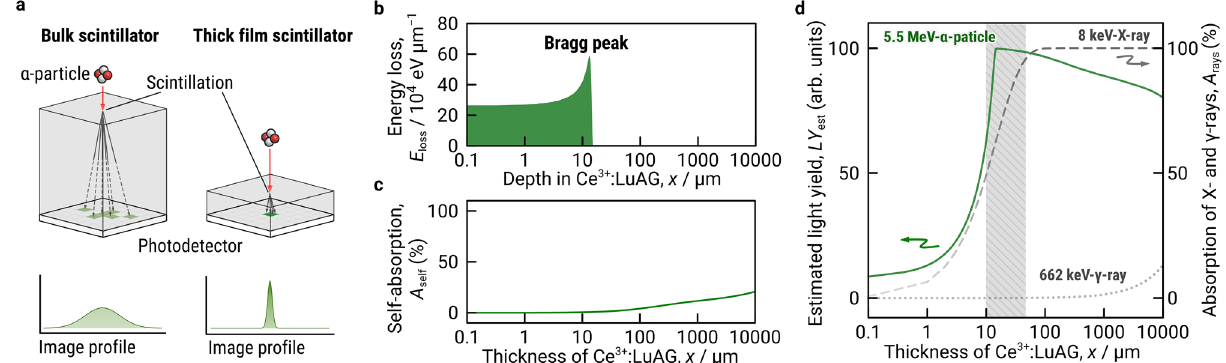
Figure 1. Estimation of optimal thickness of Ce 3+ :LuAG thick film scintillator for radiation detection. ( a ) A schematic representation of bulk and thick film scintillators coupled with photodetector for α-ray imaging (upper) and expected line profiles (lower). Dashed lines illustrate the light pass of scintillation light. ( b ) SRIM simulation of the energy loss spectrum of 5.5 MeV α-particle traveled in Ce 3+ :LuAG scintillator. ( c ) Calculated self-absorption of Ce 3+ :LuAG scintillator as a function of thickness of the Ce 3+ :LuAG scintillator for 5.5 MeV α-particle-induced radioluminescence of the Ce 3+ :LuAG scintillator. ( d ) Estimated light yield of Ce 3+